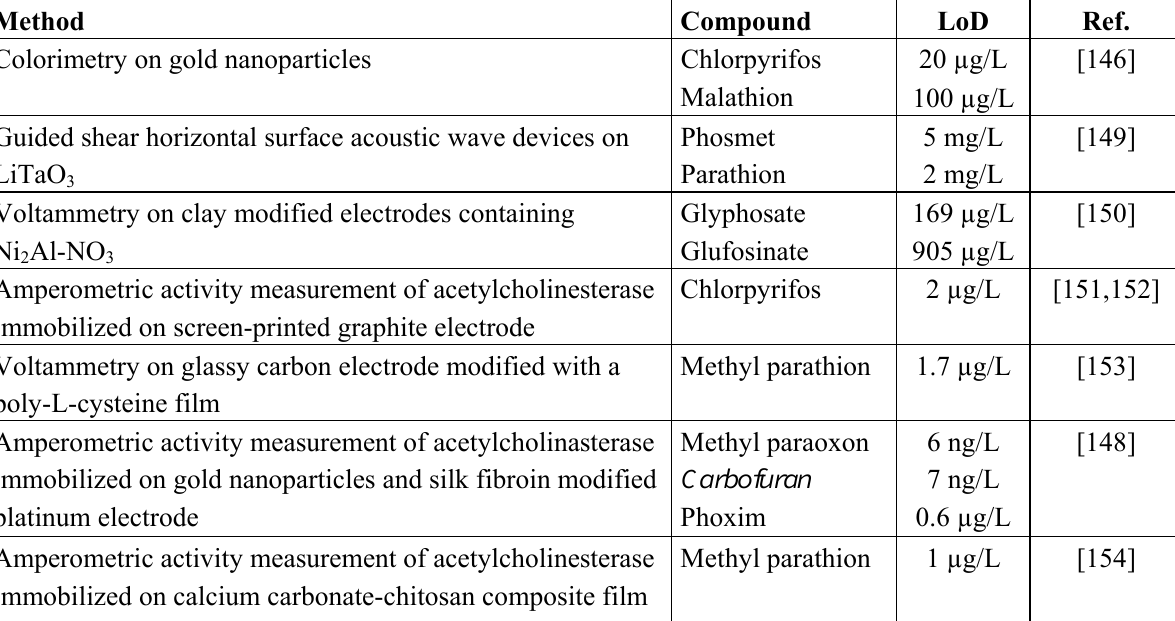
Table 11 : Micro-sensors for organophosphate and carbamates (in italics) determination in water. WFD priority organic substance in bold